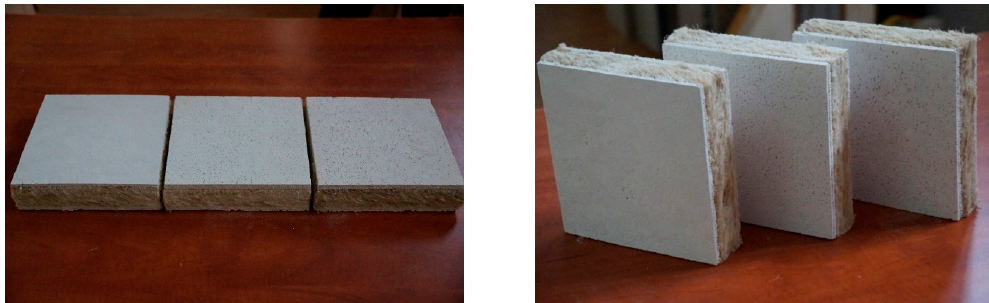
Figure 1. Multi-layered composite panels with perlite in different particles sizes: from right to left, “izo-pat 5/100” perlite sample (S 1 ), “120 mediu” perlite sample (S 2 ), “izo-pat 5/200” perlite sample (S 3 ).